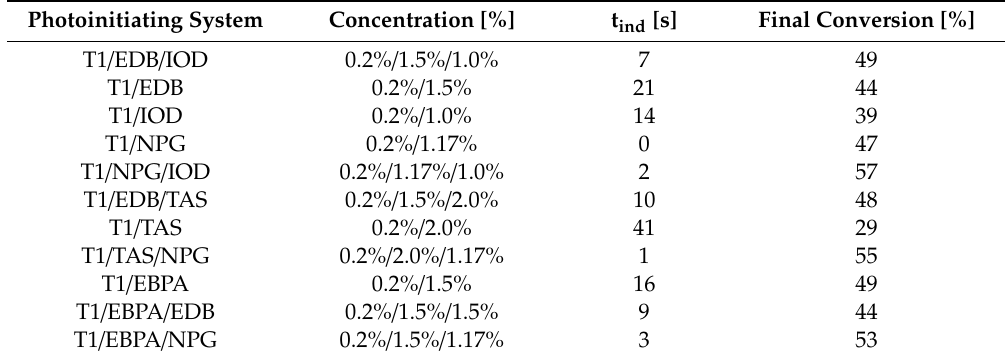
Table 6. Functional group conversions of the acrylate monomer TMPTA using di ff erent two- and three-component photoinitiating systems after 300 s of irradiation LED@420 nm (I 0 = 0.60 mW · cm − 2 ), concentration of initiating systems, d α / dt and induction